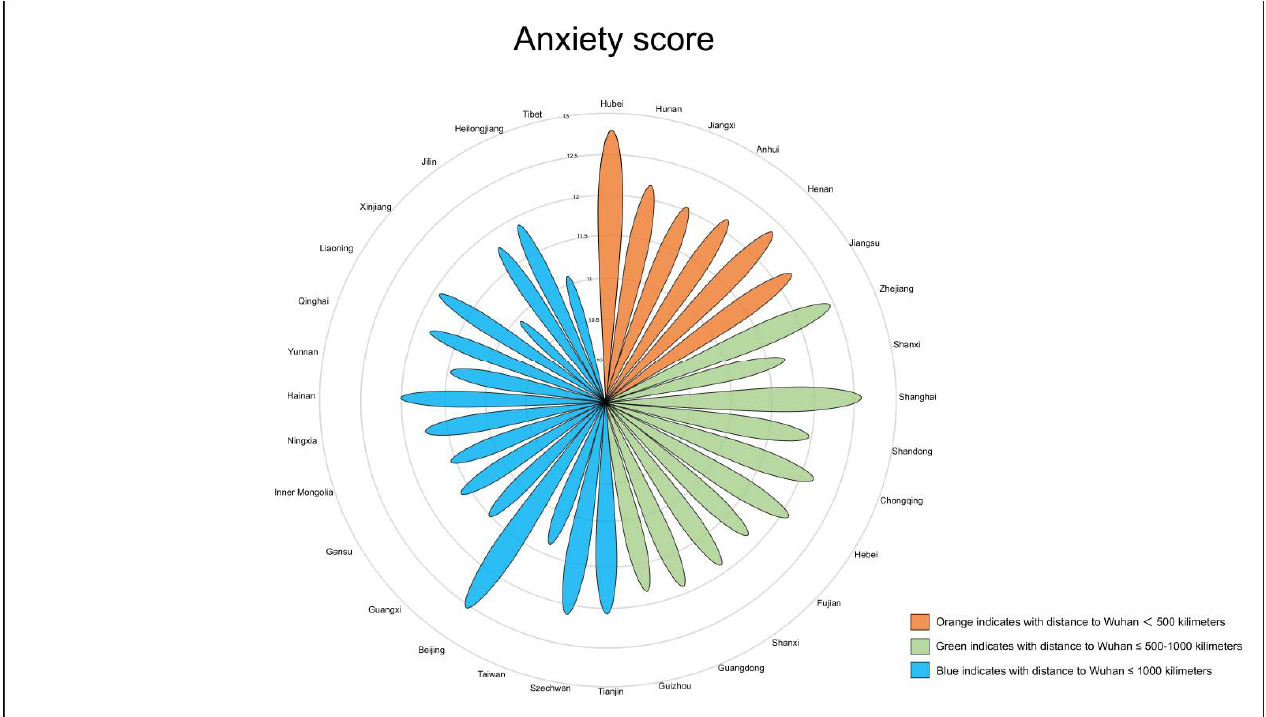
Figure 2. Anxiety scores by province.